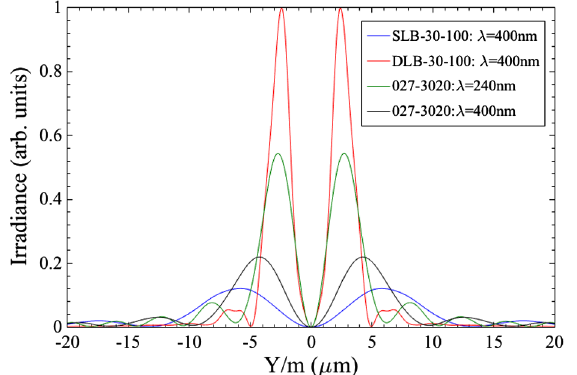
FIG. 8. Simulated output beam size versus input beam size. The line in red shows the ideal curve where output beam size equals the input beam